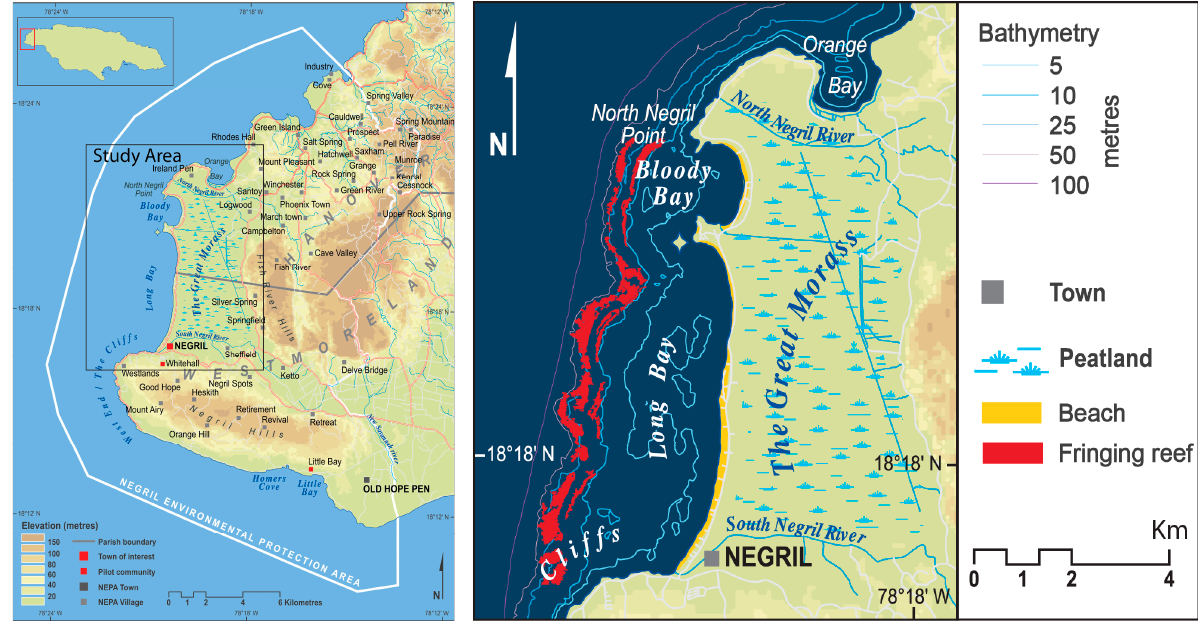
Figure 1. Location map of the study